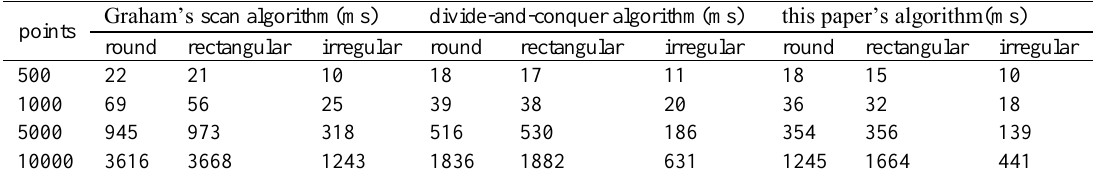
Table 1. Comparison of three